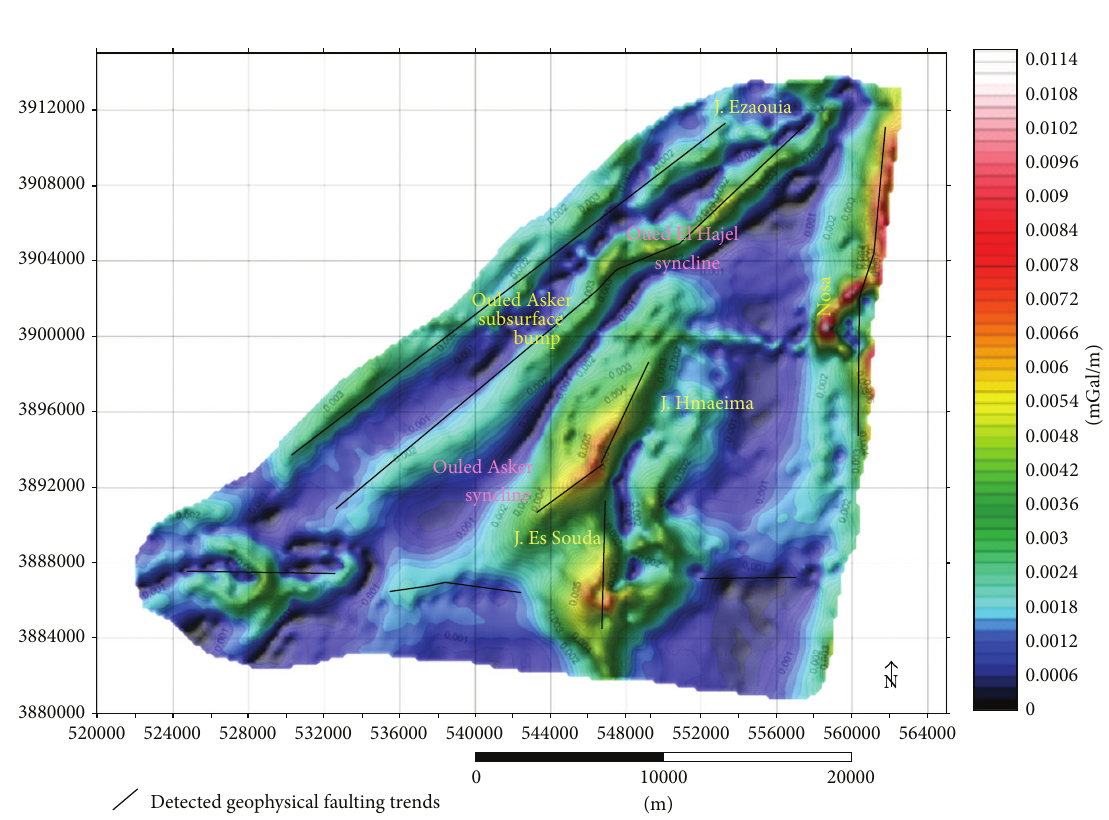
Figure 7: The structural lineaments after the horizontal gradient gravity magnitude map